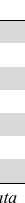
Beta Std. Beat Sig. -0.198